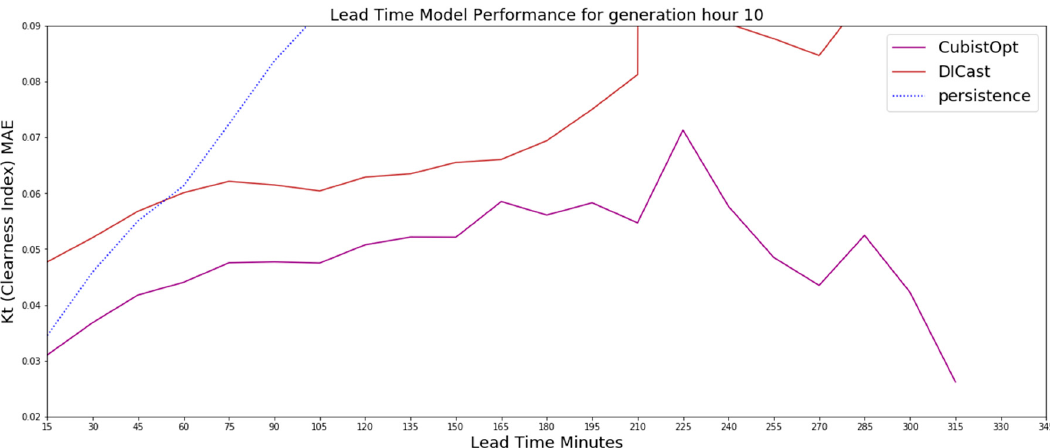
Figure 6. The 10 UTC generation time results on the test dataset for the CubistOpt method, the clearness index persistence and the DICast forecasts, which show that the CubistOpt (purple line) method has the lowest error over all time periods.